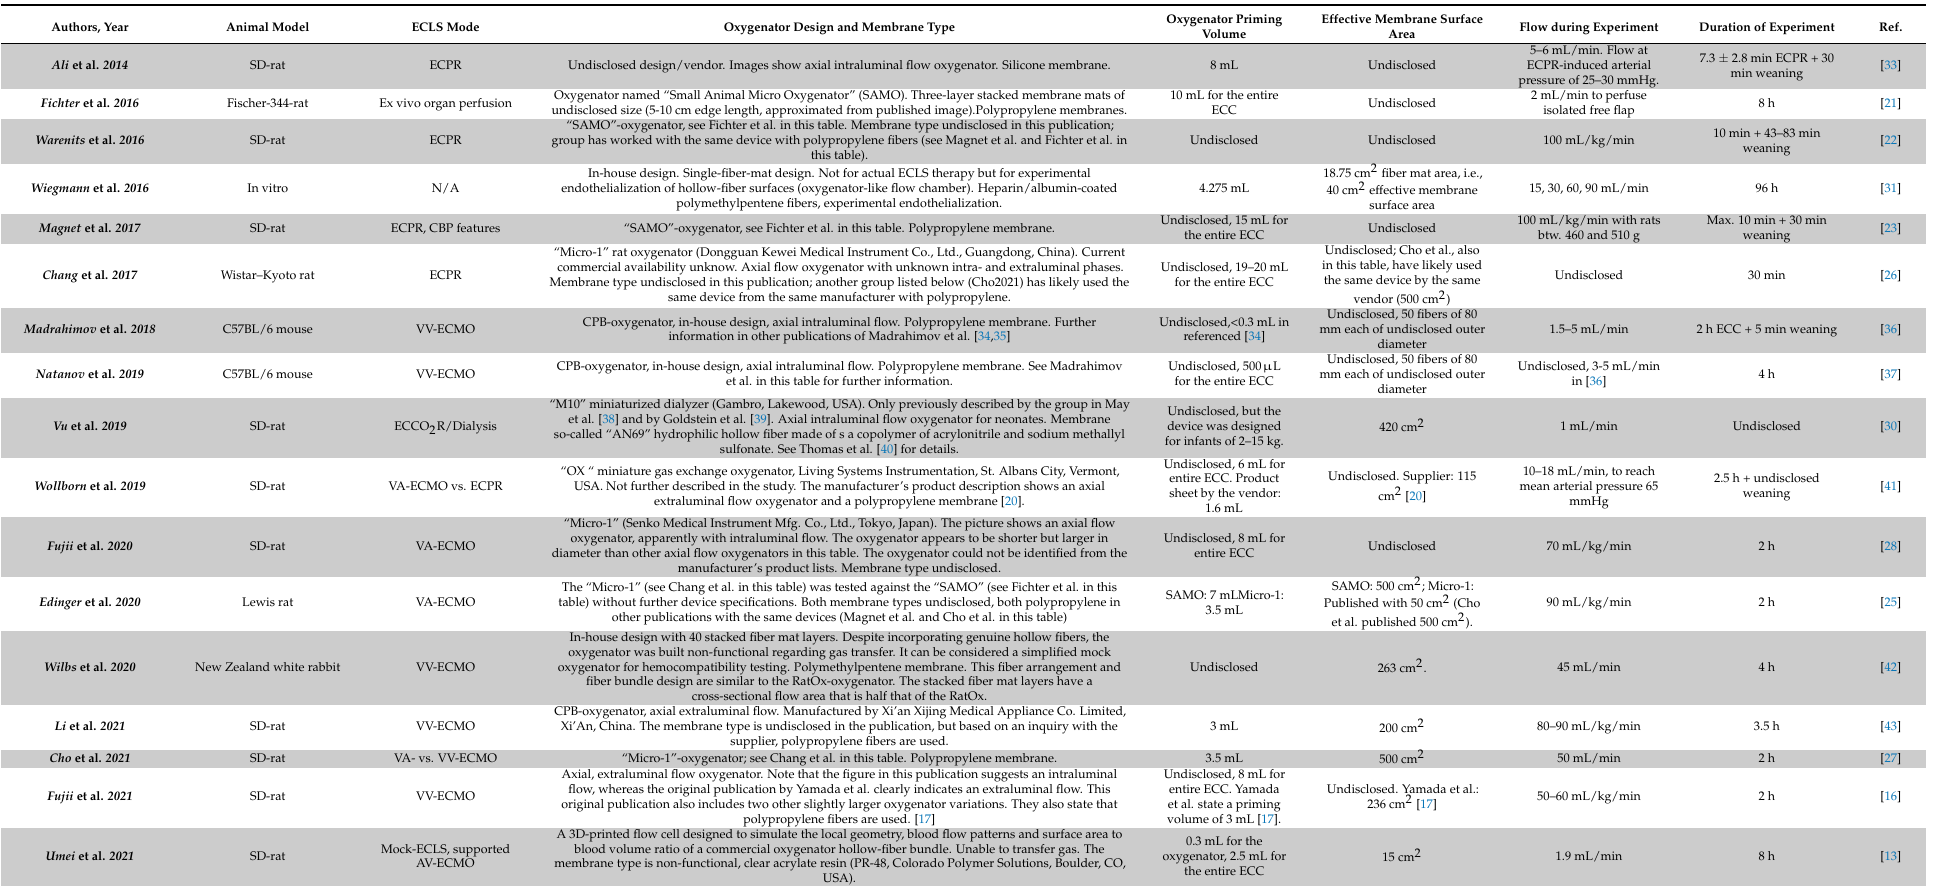
Table 1. Rodent ECLS models. Details on test setup and oxygenator specifications. ECC: Extracorporeal circuit; ECPR: Extracorporeal cardiopulmonary resuscitation; CPB: Cardiopulmonary bypass; VV-ECMO: Veno-venous extracorporeal membrane oxygenation; VA: Veno-arterial; AV: Arterio-venous; ECCO 2 R: Extracorporeal CO 2 removal. SD: Sprague